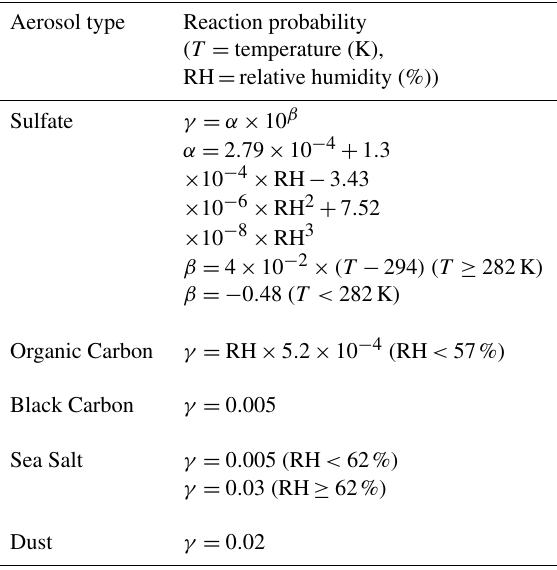
Table 6. List of γ values used in TOMCAT for heterogeneous up- take of N 2 O 5 by